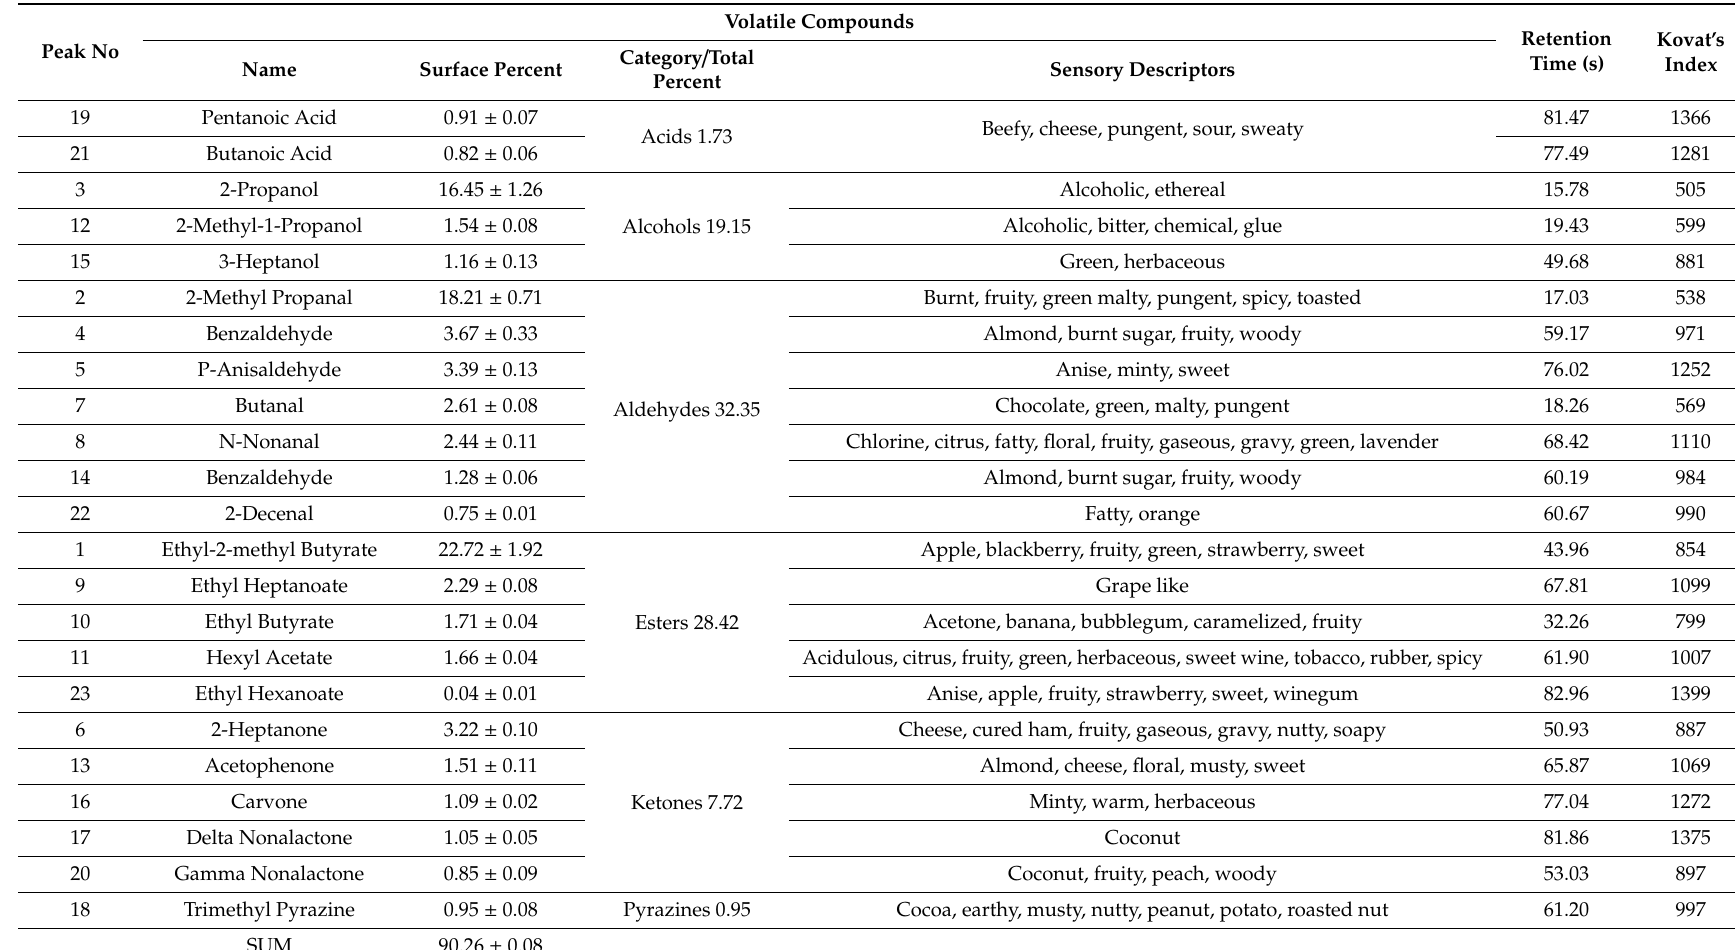
Table 2. Headspace volatile compounds of soybean variety: